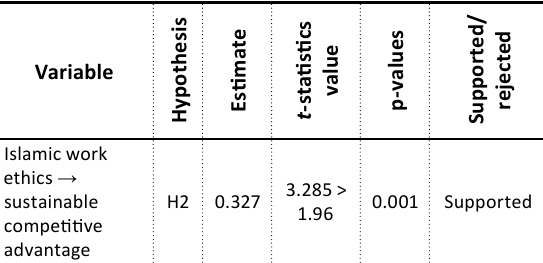
Table 2. Path coefficient for Islamic work ethics